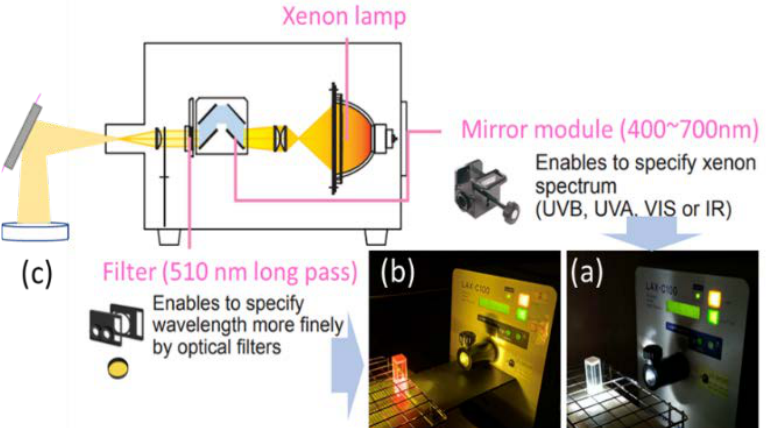
Figure 1. Schematic diagram of light source conditions. The proprietary mirror module (400~700 nm) with only the desired wavelength range (white light) from the xenon light source ( a ). The system could also emit 510~700 nm by the bandpass 510 nm filter ( b ). The 15 mW/cm 2 light power was output to the dish surface ( c